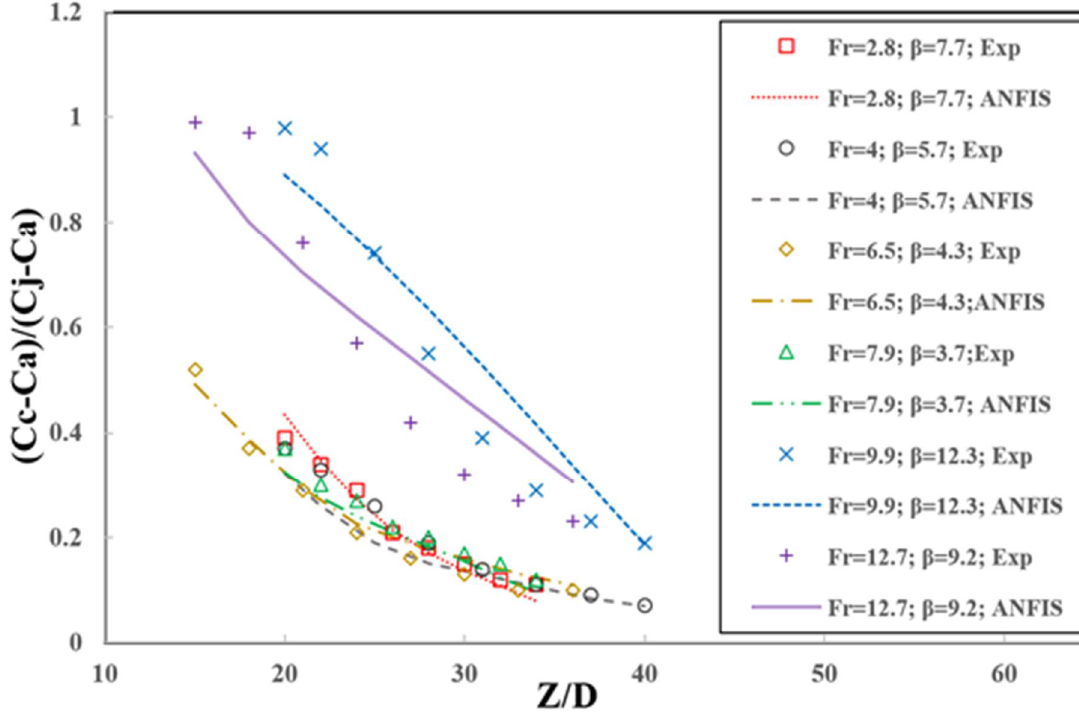
Figure 2. Observed and predicted concentration profiles.